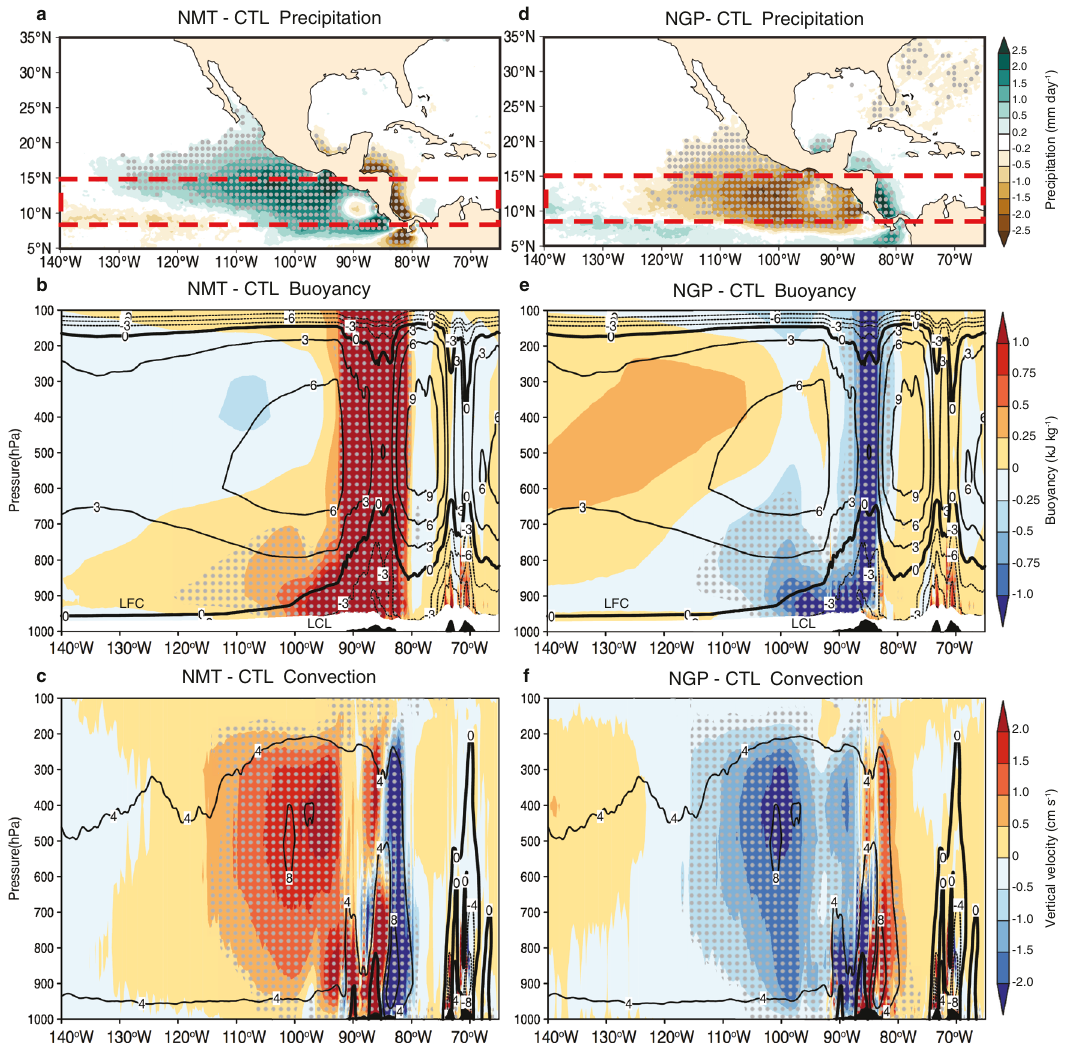
Fig. 5 Topography-induced responses of thermodynamic climate states in the ENP. a The precipitation difference (mm day − 1 ; color shading) using no mountains (NMT) minus control (CTL) ensemble mean. Vertical cross-section averaged from 8°N to 15°N [red dashed box in panel a] of b buoyancy (kJ kg − 1 ; positive upward; LFC the level of free convection, and LCL the lifted condensation level. Buoyancy values within LCL are masked out with white shadings as water vapor are not saturated. See “ Methods ” for details. c Vertical velocity (cm s − 1 ) difference (color shadings) using NMT minus CTL ensemble mean. CTL mean values are shown as contours. d – f Similar to ( a – c ), but for no mountain gaps (NGP) minus CTL. Gray dots denote statistical con fi dence at the 95% level based on the two-sided t test. Black shadings indicate the sketchings of averaged